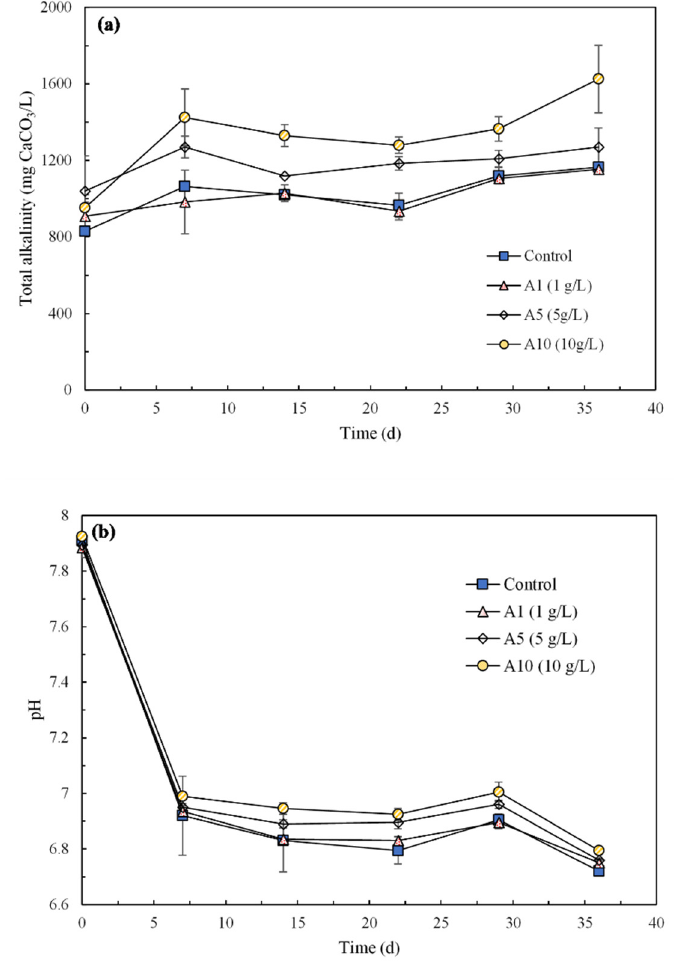
Figure 6. Changes of TA ( a ) and pH ( b ) during the AD of dairy manure with the addition of different concentrations of